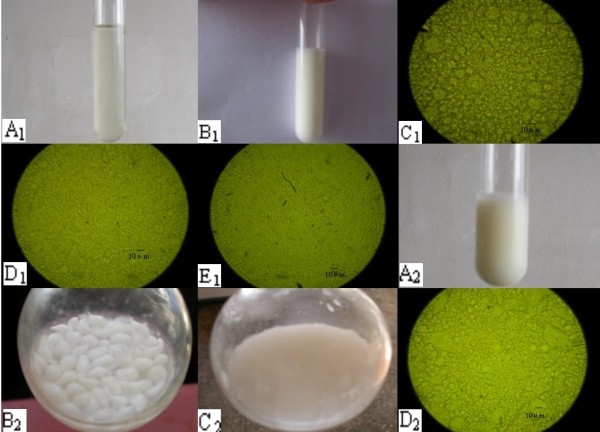
Size and form of ME-RCA and MBG-RCA in a simulated gastrointestinal environment in vitro. A1 - ME-RCA translucent appearance; B1 - ME-RCA in a gastrointestinal environment; C1 - ME-RCA in artificial gastric fluid (× 100); D1 - ME-RCA in small intestinal fluid (× 100); E1 - ME-RCA in colonic fluid (× 100) A2 - appearance of MBG-RCA; B2 - MBG-RCA in artificial gastric fluid and small intestinal fluid; C2 - MBG-RCA in colonic fluid; D2 - MBG-RCA in colonic fluid under microscope (× 100) (after arriving at the stomach, the microemulsion-gel system encountered acid and became a gel)